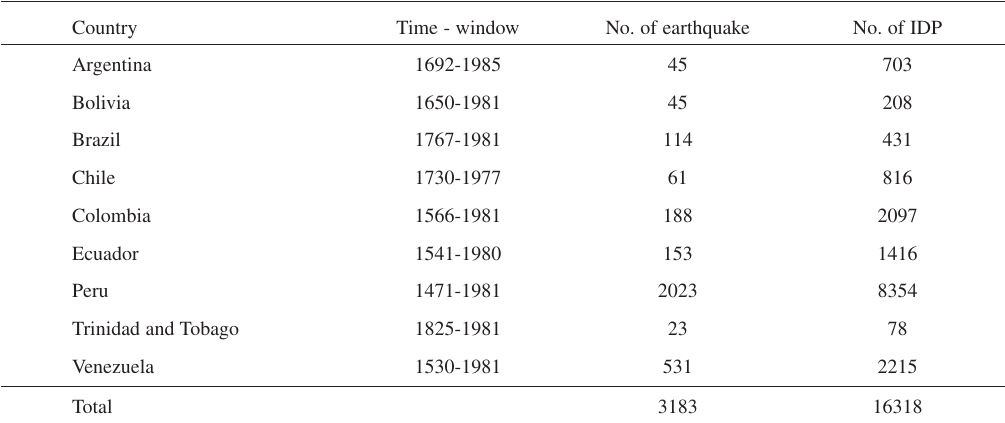
Table I. Time-windows, number of earthquakes and related IDP in the CERESIS database.